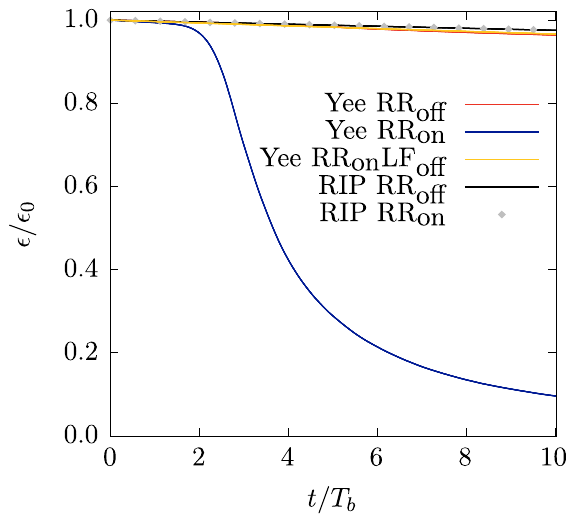
FIG. 6. Relative particle energy over time for an ultrarelativistic electron bunch propagating in vacuum. Additionally, the yellow line represents the simulation where the fields are updated with the Yee solver and the particles are solely pushed by the RR force; i.e., the momentum change by the LF has been